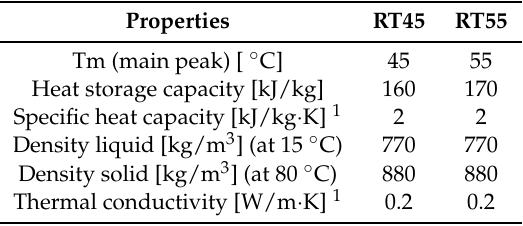
Table 1. Thermal properties of paraffin waxes RT45 and RT55 given by manufacturer’s datasheet